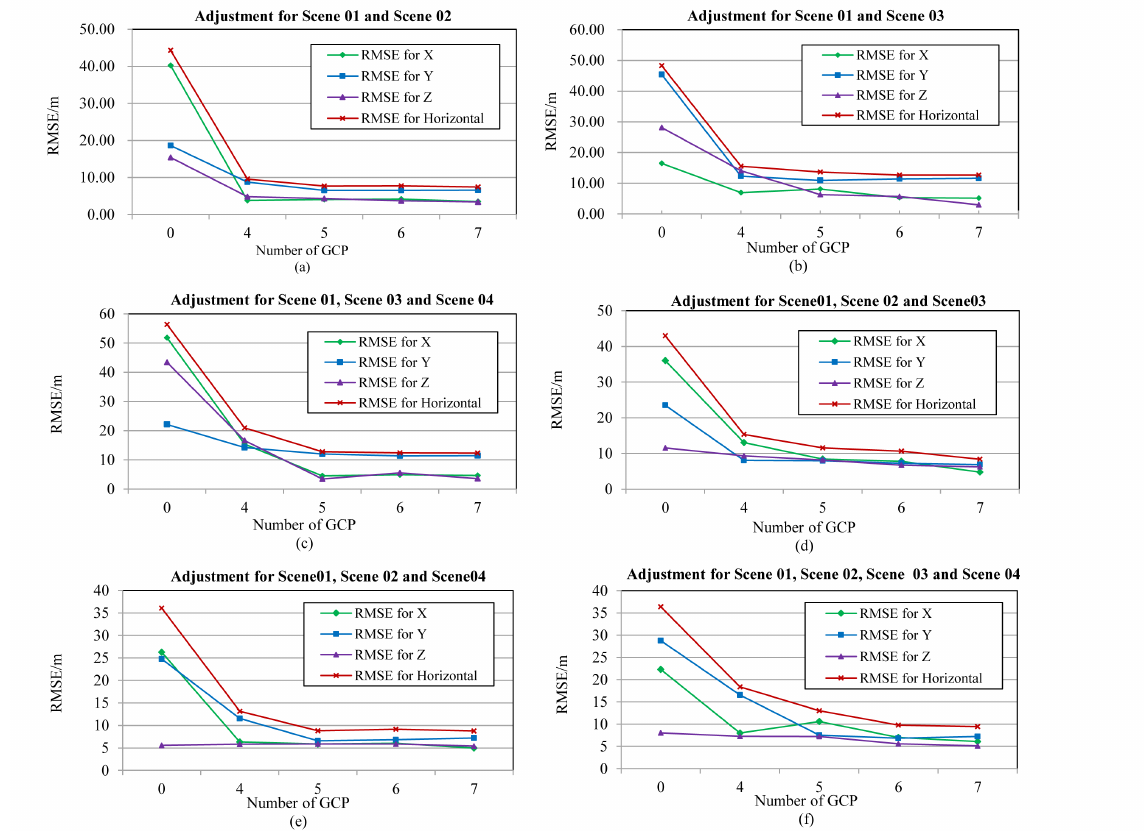
Figure 5. Result of conventional image positioning with different numbers of GCPs using SPOT-5 images: ( a ) accuracy of adjustment for Scenes 01 and 02 with different number of GCPs; ( b ) accuracy of adjustment for Scenes 01 and 03 with different number of GCPs; ( c ) accuracy of adjustment for Scenes 01, 03 and 04 with different number of GCPs; ( d ) accuracy of adjustment for Scenes 01, 02 and 03 with different number of GCPs; ( e ) accuracy of adjustment for Scenes 01, 02 and 04 with different number of GCPs; ( f ) accuracy of adjustment for Scenes 01–04 with different number of